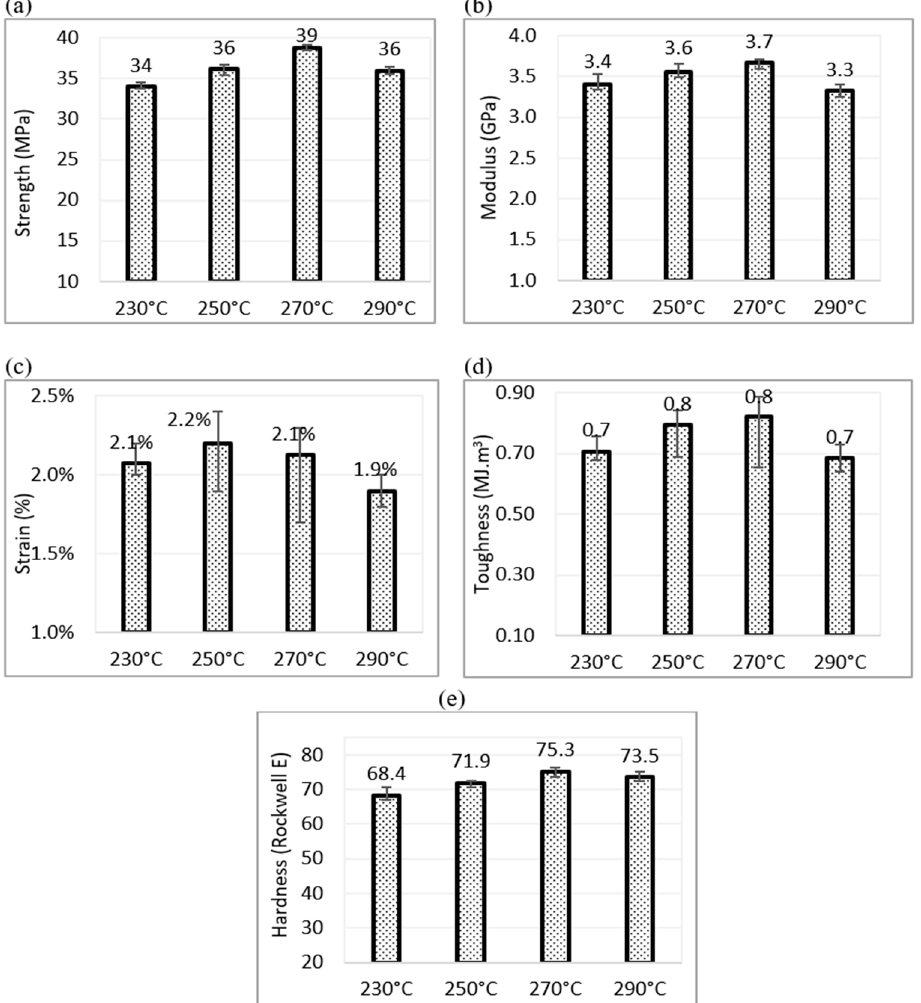
Figure 10. Tensile properties of amorphous CF-ABS composite at different printing temperatures: ( a ) ultimate tensile strength, ( b ) modulus, ( c ) ductility, ( d ) toughness, ( e ) hardness .